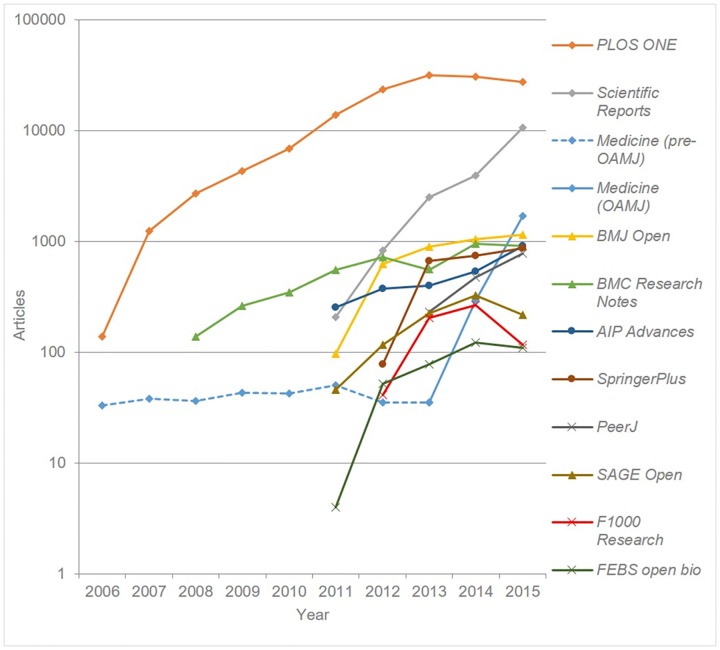
Mega-journal output by year (base 10 logarithmic scale used for y-axis).